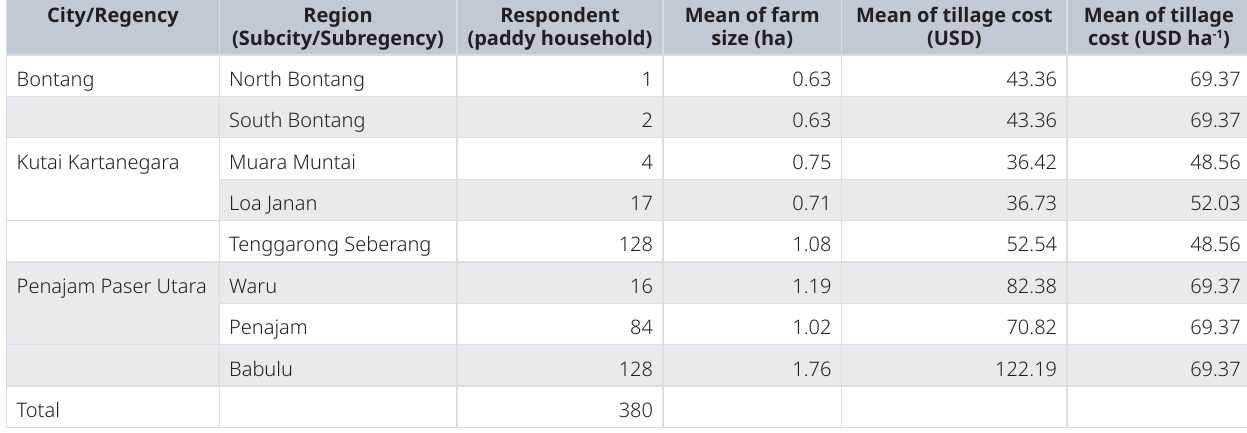
Table 4. Number of respondents and mean farm sizes and tillage costs in East Kalimantan the year 2014. City/Regency